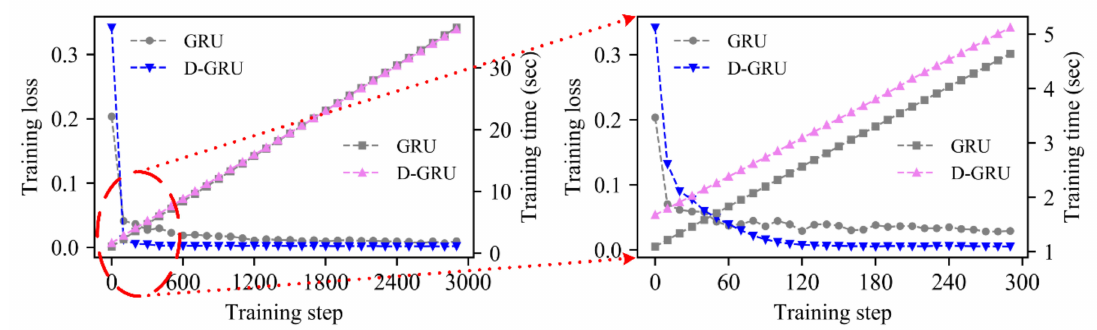
Figure 10. Training loss and training time with respect to the training